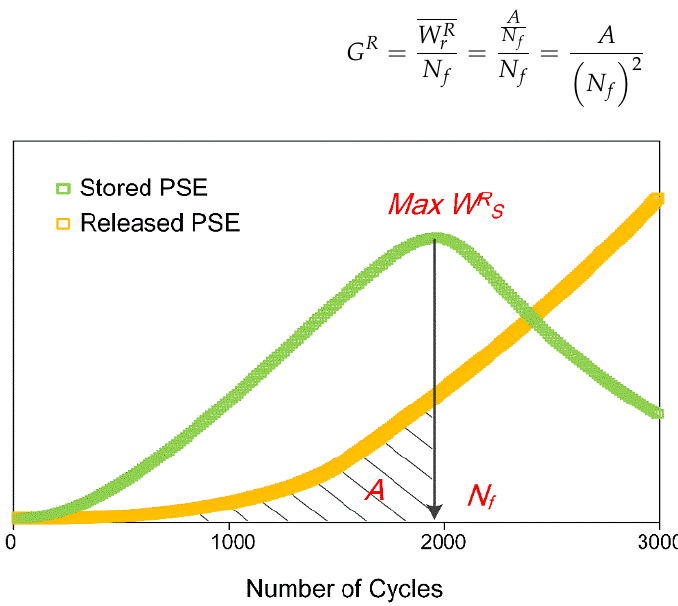
Figure 2. PSE-based failure Figure 2. PSE ‐ based failure definition.